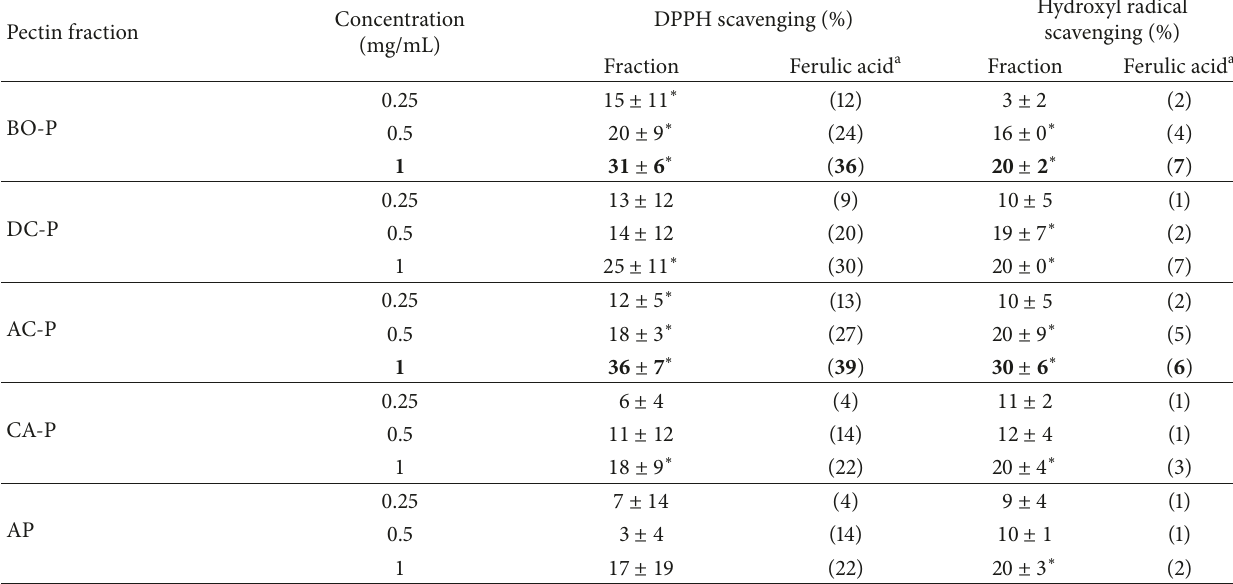
Table 3: The radical scavenging activities of pectin fractions in comparison with calculated activity of ferulic acid contaminant. Pectin